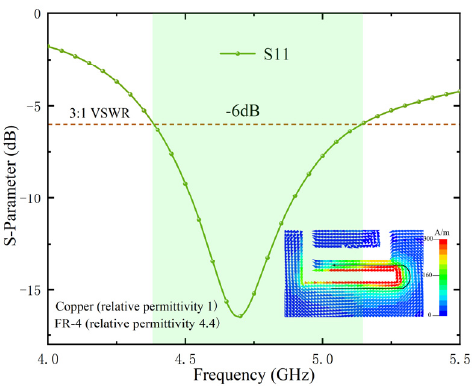
Figure 3. Surface current distributions of the resonance and simulates the reflection coefficient of the antenna element.